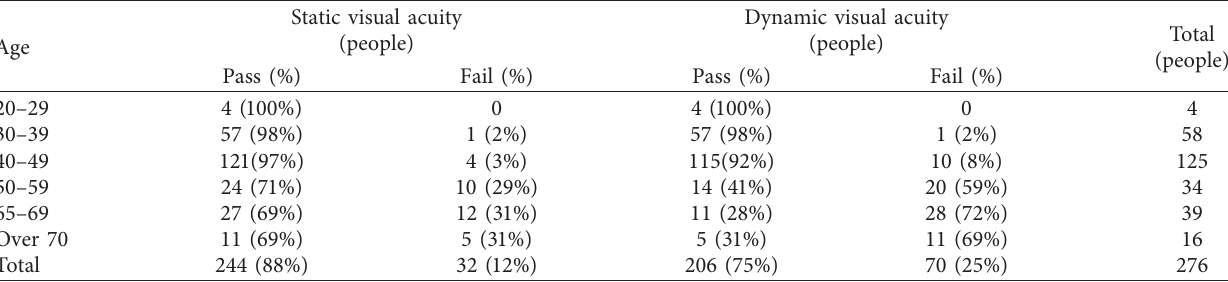
Table 1: Results of the vision test in different age groups.